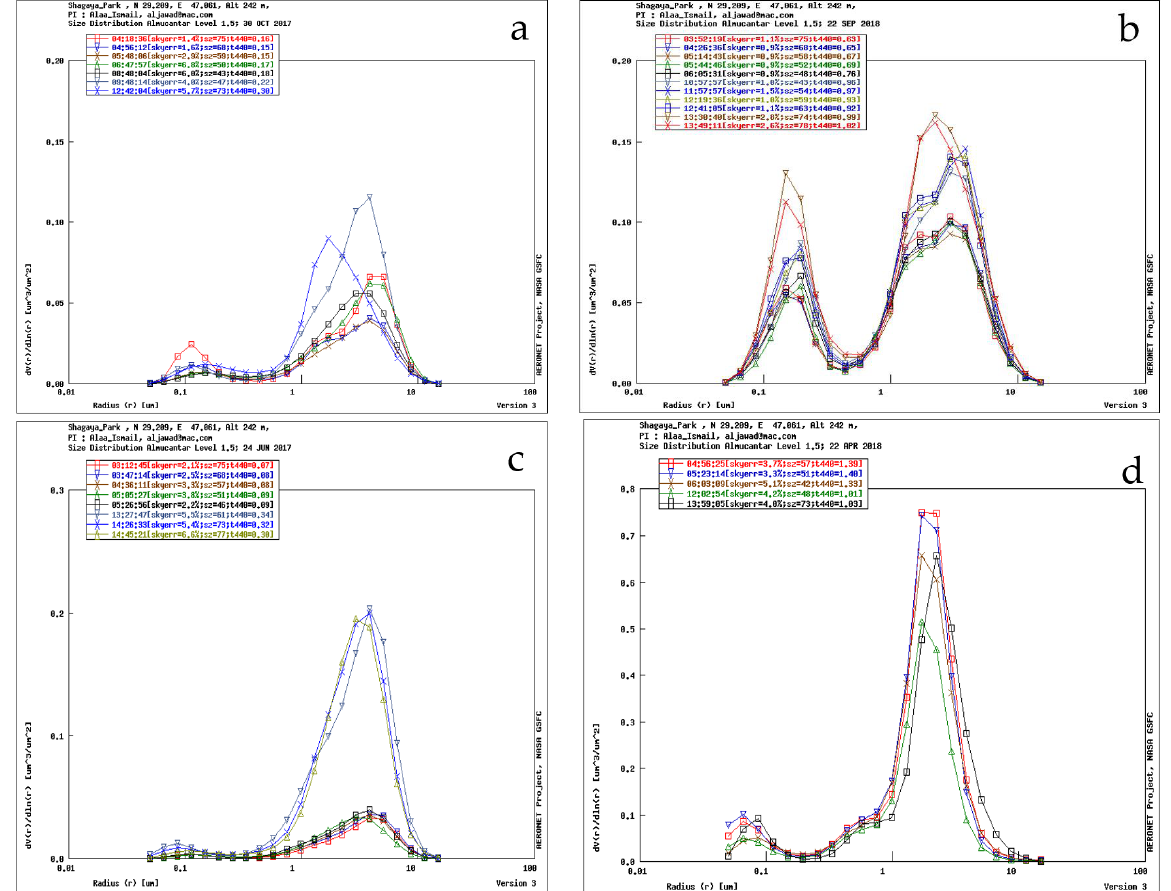
Figure 17. A trimodal AOT/Angstrom for sand and dust storms (SDS) of three combined sources, mostly from the Mesopotamian Flood Plain ( a ), from the two hotspots ( b ), characterized by a high peak at 0.25 µ m, and the Western Desert of Iraq ( c , d ).